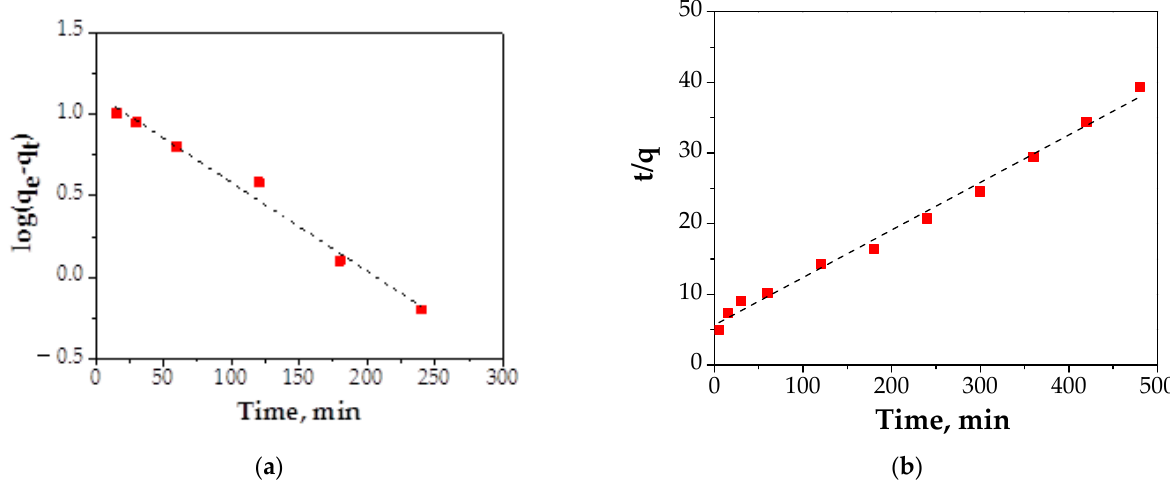
Figure 12. Kinetic adsorption plots: ( a ) pseudo-first-order model; ( b ) pseudo-second-order model . Table 4. Kinetic parameters of Cu (II) adsorption onto FA/Fe 3 O 4. Kinetic Model Kinetic